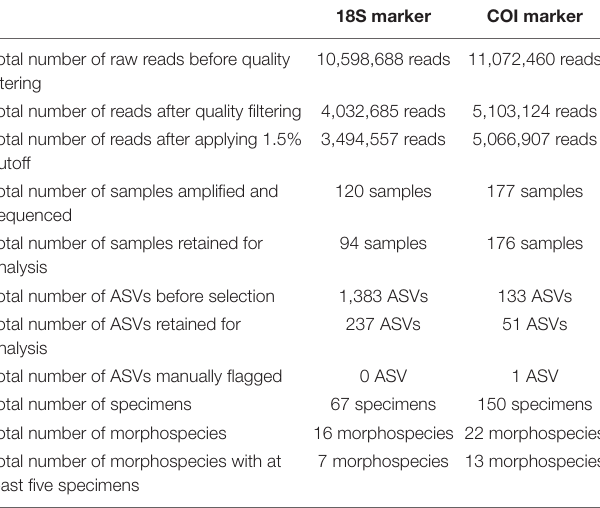
TABLE 2 | Statistics on number of reads, samples and ASVs before and after quality filtering (see also Supplementary Table 4 for more information on the impact of the quality filtering on the number of reads per